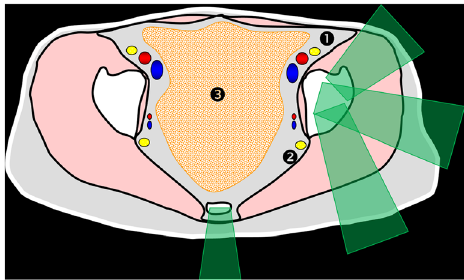
Fig. 10 Diagram of the pelvis at the acetabular roof level showing the principal structures to avoid ( 1 femoral nerve and external iliac vessels, 2 sciatic nerve, 3 visceral structures) and the safe approaches ( green areas )